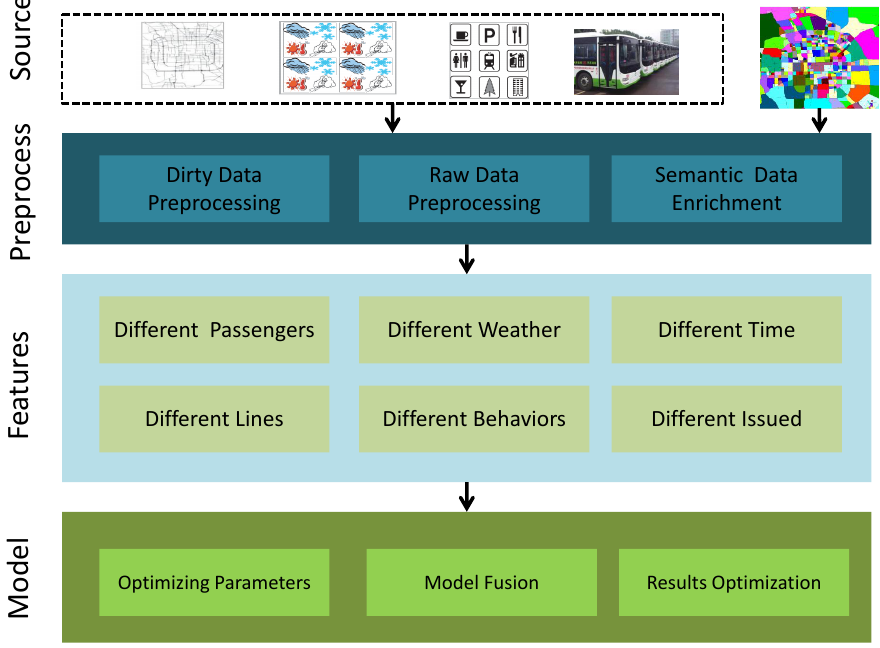
Figure 1. Framework for public transit forecasting using crowdsensing and semantic trajectory mining.